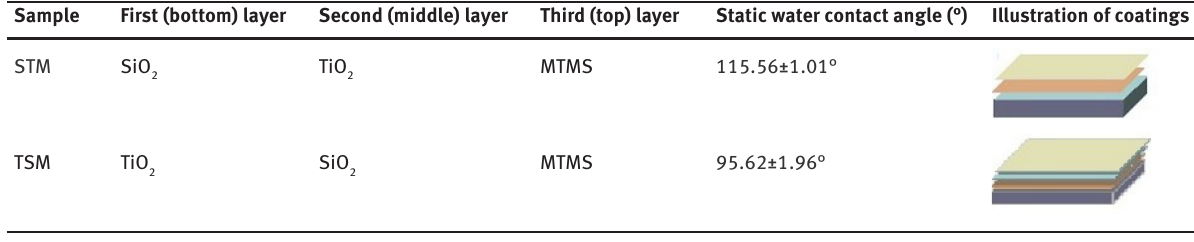
/TiO /MTMS (STM) and TiO 2 2